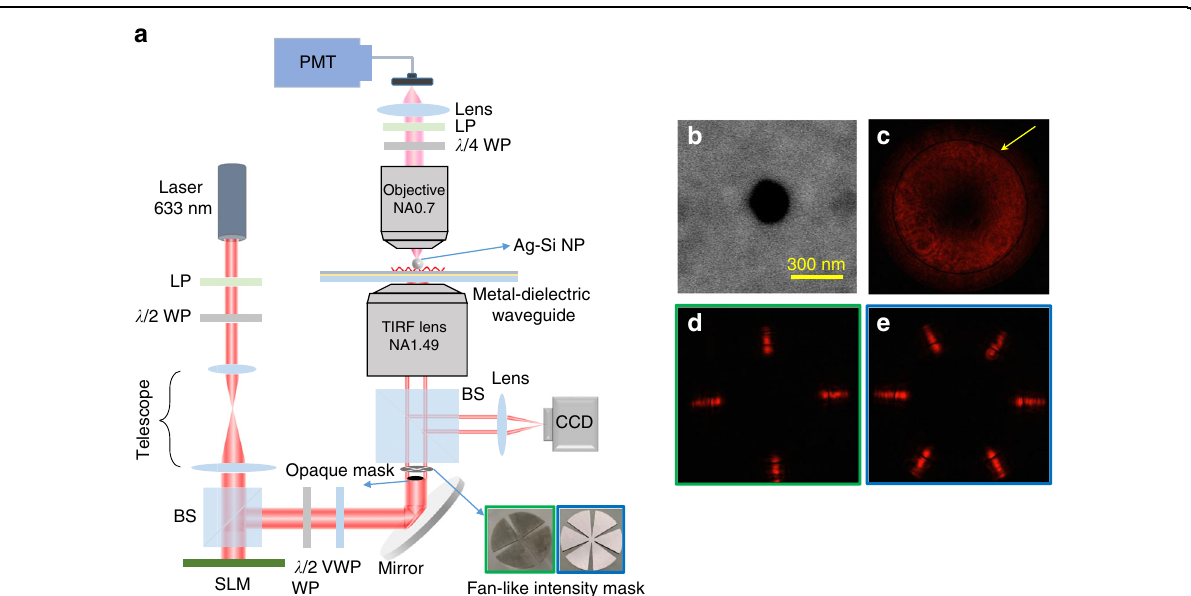
Fig. 2 Experimental con fi guration for validating the effectiveness of the proposed anapole probe and measuring the magnetic photonic spin topological structures. a Schematic of the setup, b SEM image of the designed core-shell nanoparticle, c image of the re fl ected beam captured at the CCD mounted on the back focal plane of the excitation TIRF objective lens — the dark ring indicates the excitation of a TE mode in the metal-dielectric waveguide by the incident azimuthal polarized beam, and d , e images of the re fl ected beams when a fan-like intensity mask with 4-fold symmetry (for generating a spin-Meron lattice) and 6-fold symmetry (for generating a spin-Skyrmion lattice) were inserted into the incident beam. LP linear polarizer; λ /2 WP half-wave plate; VWP vortex wave plate; BS beam splitter; SLM spatial light modulator; λ /4 WP quarter-wave plate; PMT photo-multiplier tube; CCD charge-coupled